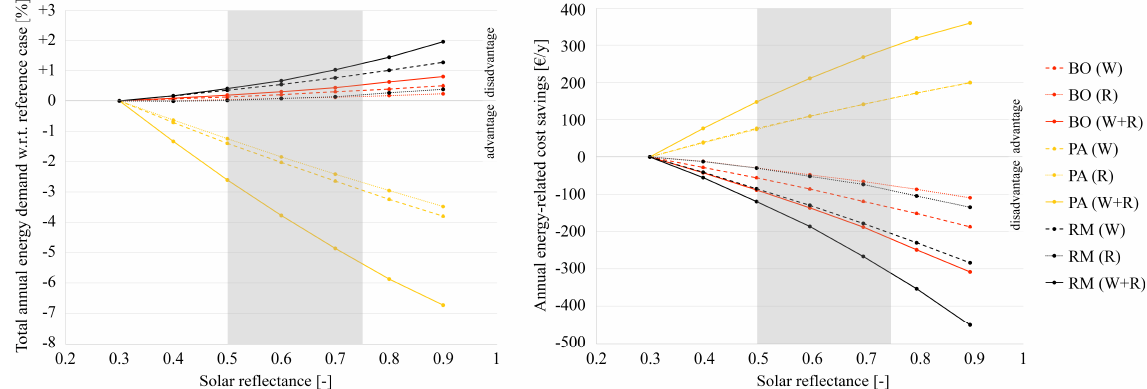
Figure 5. Annual energy demand of the reference building and related cost savings according to location (BO = Bologna, PA = Palermo, RM = Rome), treated envelope components (W if only walls, R if only roof, W+R for both) and solar reflectance of the "cool" product. In grey the range between the albedo of the high-reflective dark material ( r = 0 . 5) and that of the white one ( r = 0 .